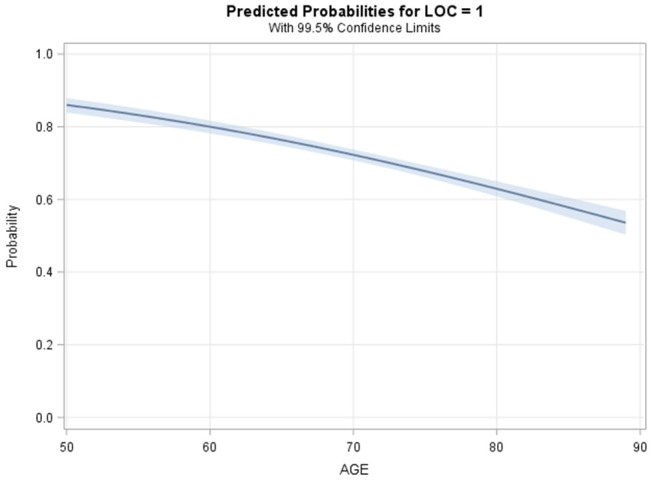
Modeled probability of documented loss of consciousness by age.